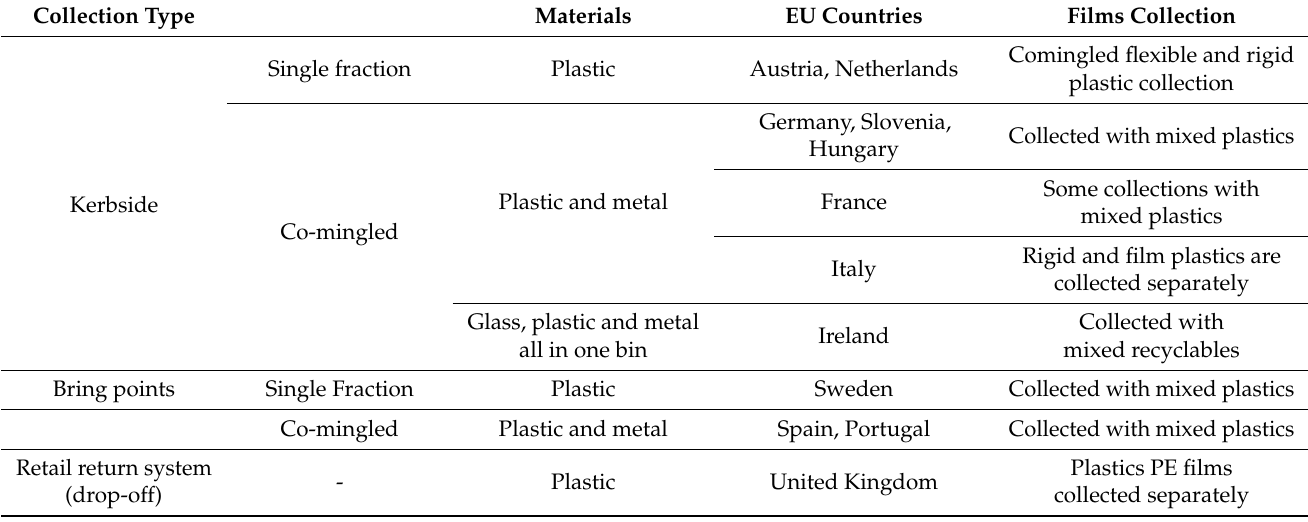
Table 2. Plastic flexible films collection schemes and programs in European countries